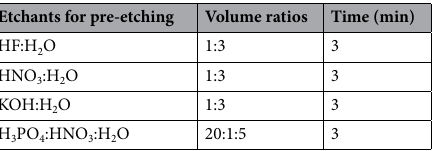
Table 2. The etchants used for the pre-etching step and their volume ratios and etching time.